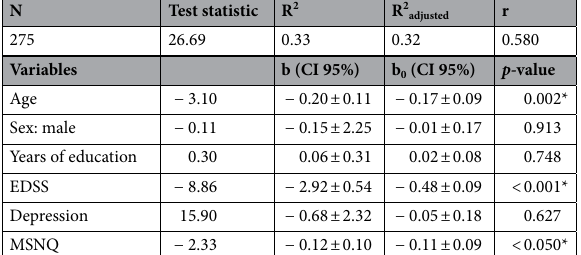
Table 3. Multiple linear regression analysis of SDMT in the total population. Statistically significant predictors (p < 0.05) are marked with *. CI 95% 95% confidence interval, EDSS Expanded Disability Status Scale, MSNQ Multiple Sclerosis Neuropsychological